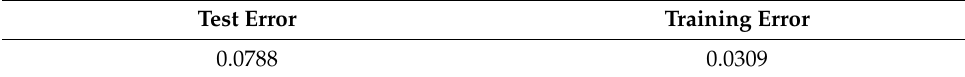
Table 2. Error of Table 2. Error of model.